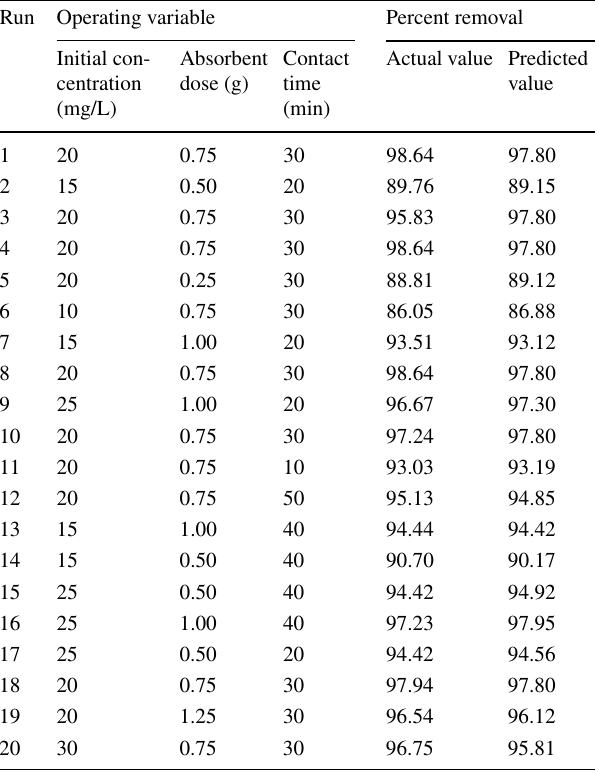
Table 6 Actual versus predicted MOD removal percentages Run Operating variable Percent